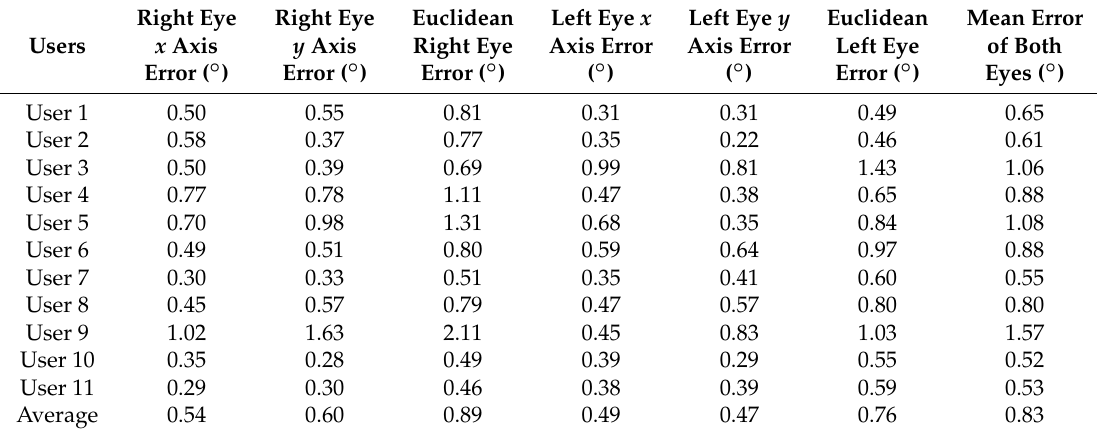
Table 2. Estimation results of gaze tracking accuracies in degrees. MSE: mean square